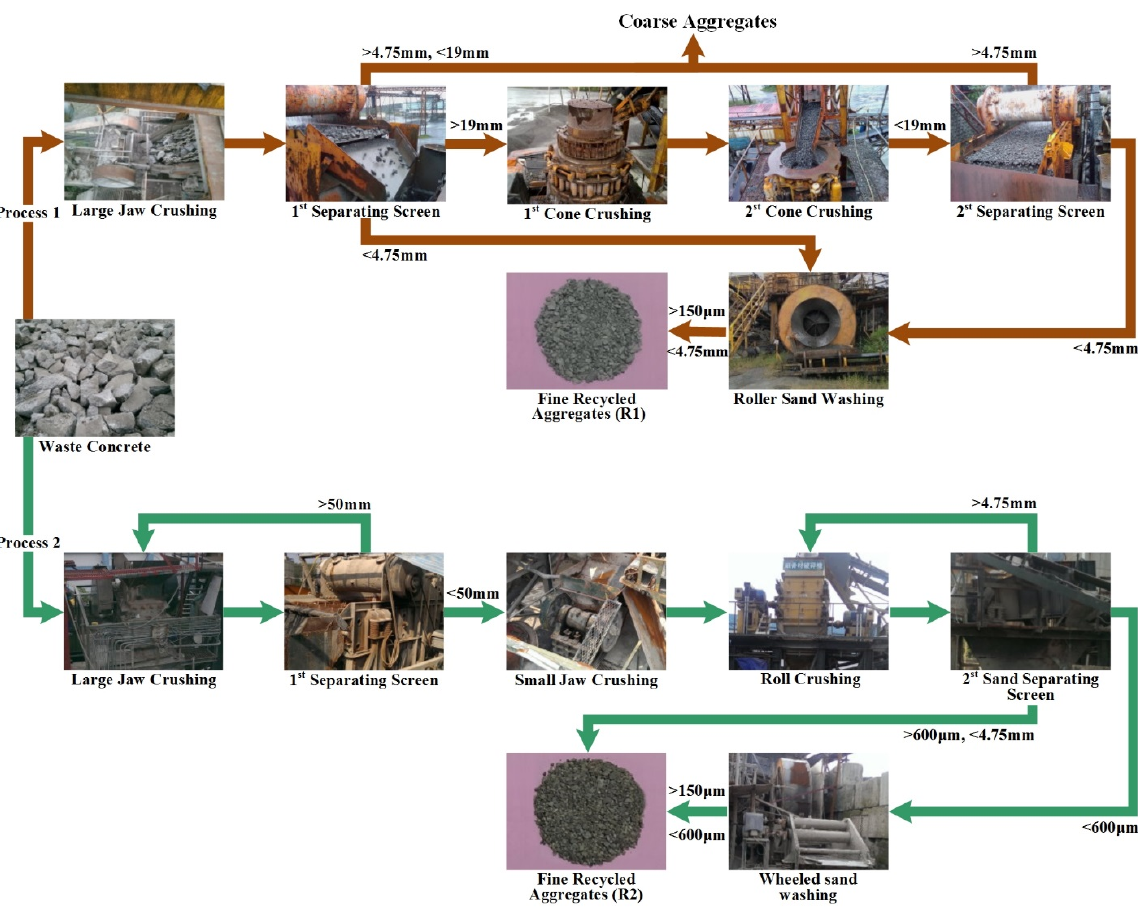
Figure 2. Processes used in the production of fine recycled concrete